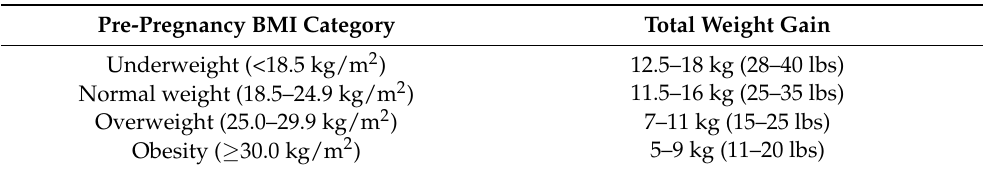
Table 1. GWG recommendations from the 2009 Institute of Medicine and National Research Council Report